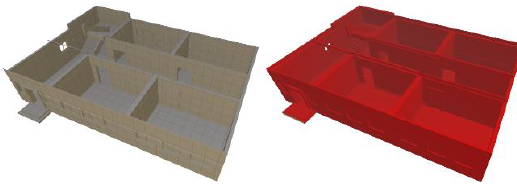
Figure 9 The input data and voxelization result